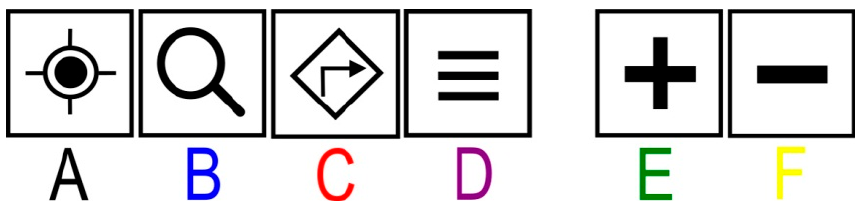
Figure 3. All buttons that we used in the graphical user interface (GUI) design. Labels refer to the description of Figure 2.